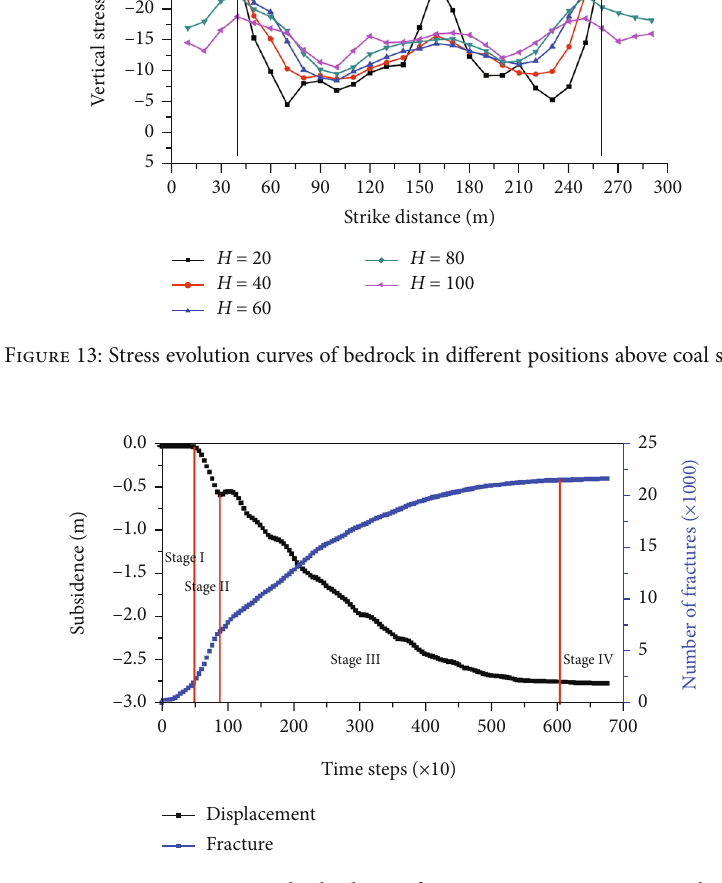
Figure 14: Fracture propagation and subsidence of monitoring point in numerical